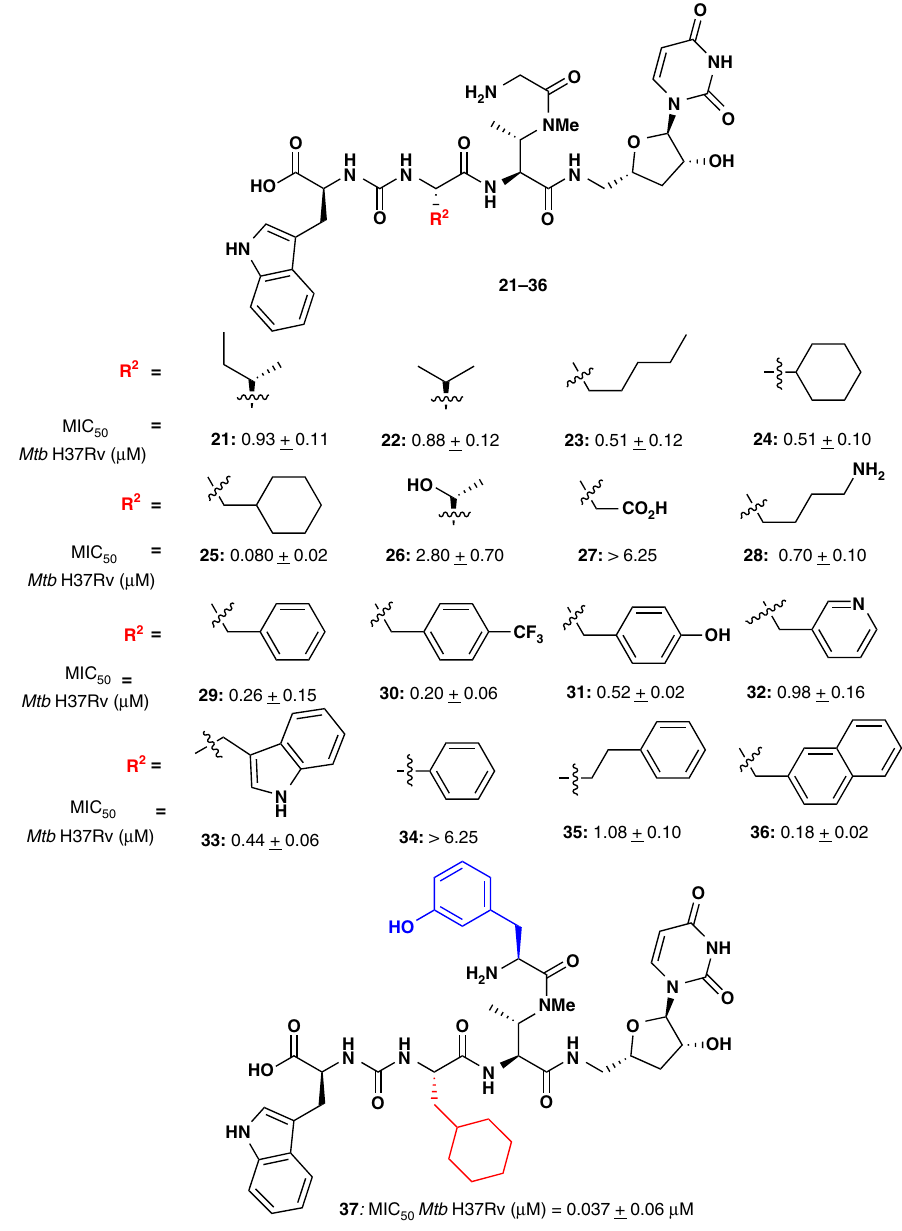
Figure 3 | Synthesis of 2nd generation sansanmycin analogues 21–37 with inhibitory activities against Mtb H37Rv. MIC 50 values represent average of two independent experiments, each performed in triplicate; positive controls RIF: MIC 50 ¼ 0.006 ± 0.002 m M; INH: MIC 50 ¼ 0.025 ± 0.005 m M; MIC 50 (HEK293) for 21–37 4 200 m